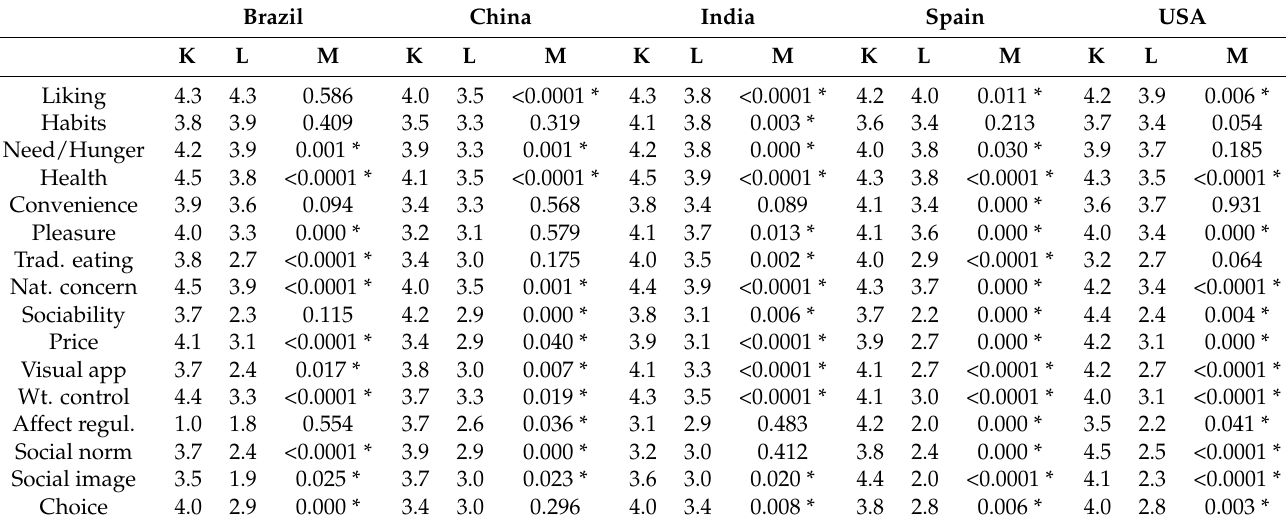
Table A10. Mean scores1 for RATA and RATING survey formats and p -values for the corresponding two-sample t -test for each motivation construct for fruits and vegetables in all five